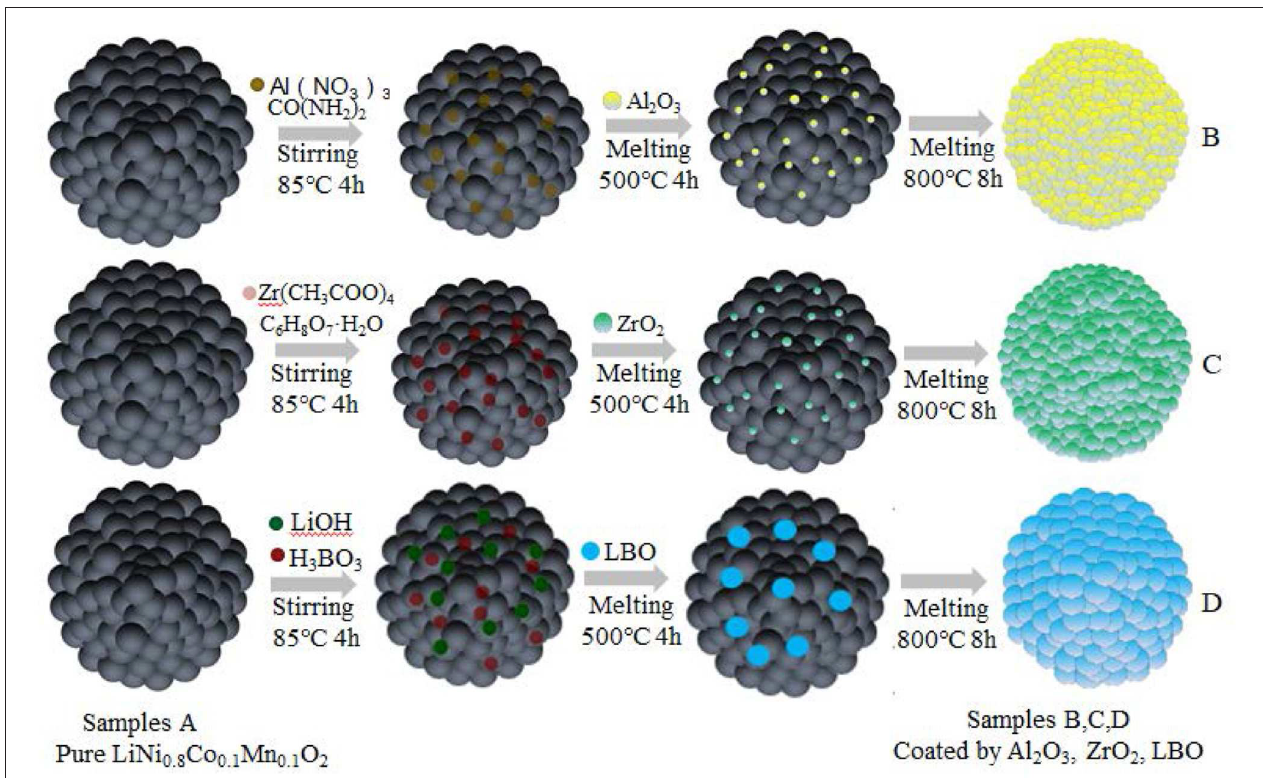
FIGURE 1 | Schematic diagrams of the preparation processes of the materials of NCM811 coated by Al 2 O 3 , ZrO 2 , and